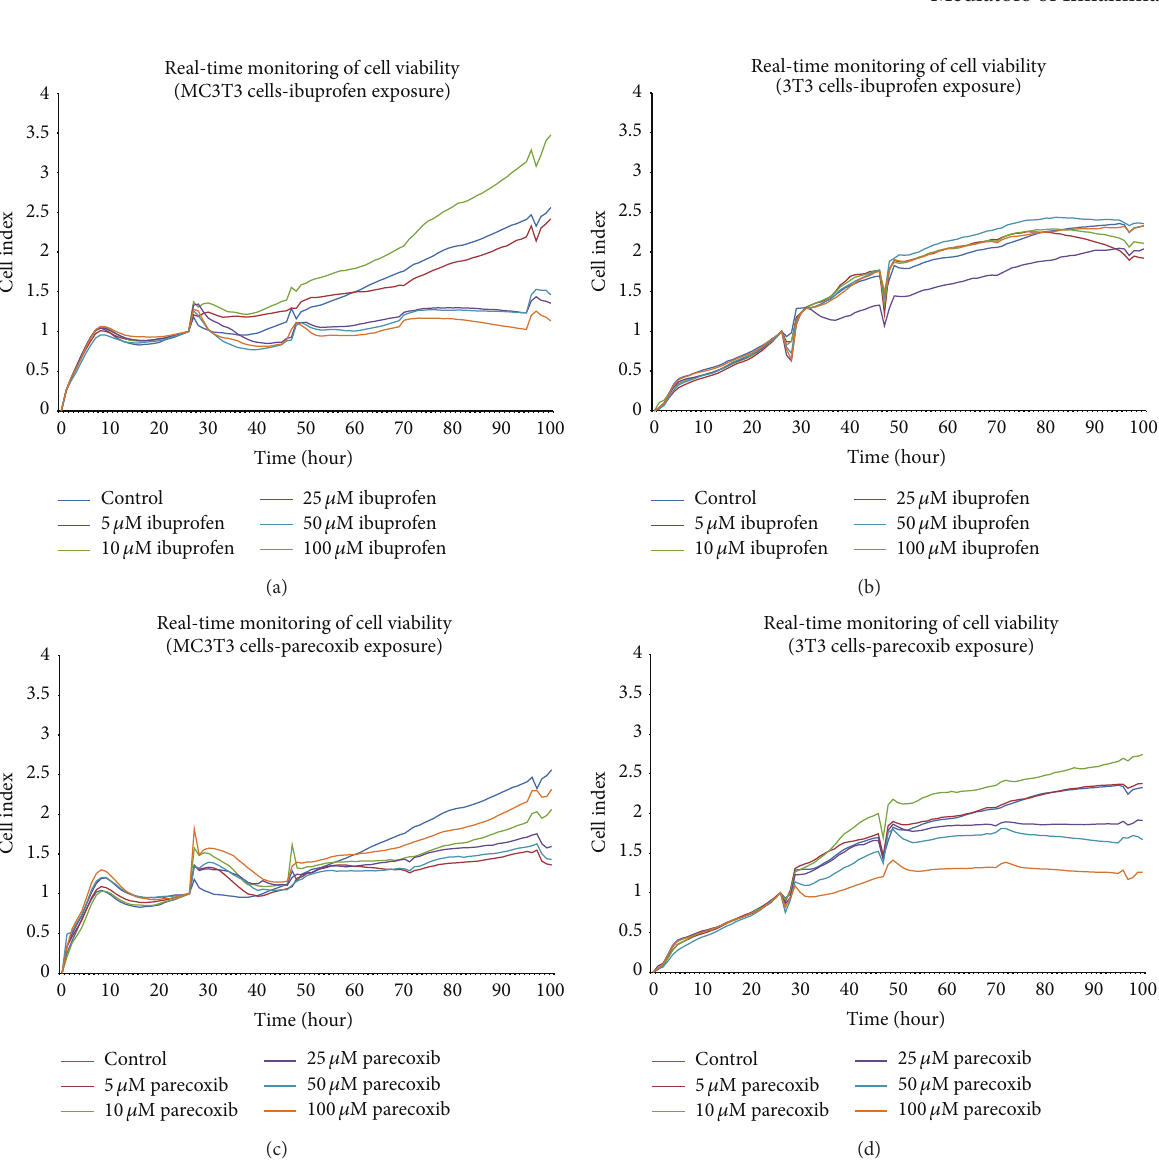
Figure 3: (a)–(d) Effects of ibuprofen and parecoxib on viability of cultured MC3T3-E1 (preosteoblast) and 3T3 (fibroblast) cells. Real-time cell viability was analyzed following the exposure to ibuprofen or parecoxib at concentrations of 0 𝜇 M, 5 𝜇 M, 10 𝜇 M, 25 𝜇 M, 50 𝜇 M, or 100 𝜇 M by xCELLigence over 100